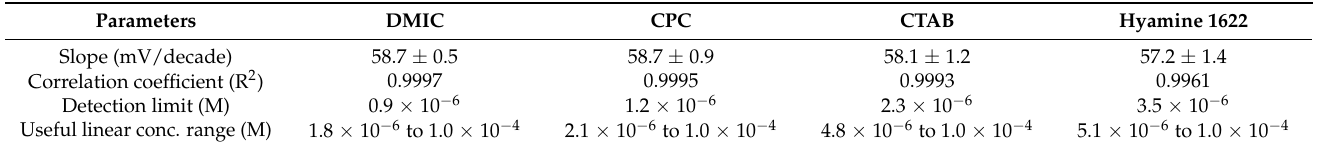
Table 1. Response characteristics of the DODI-TPB surfactant sensor to DMIC, CPC, CTAB, and Hyamine 1622 (mean values ± 95% confidence limits).